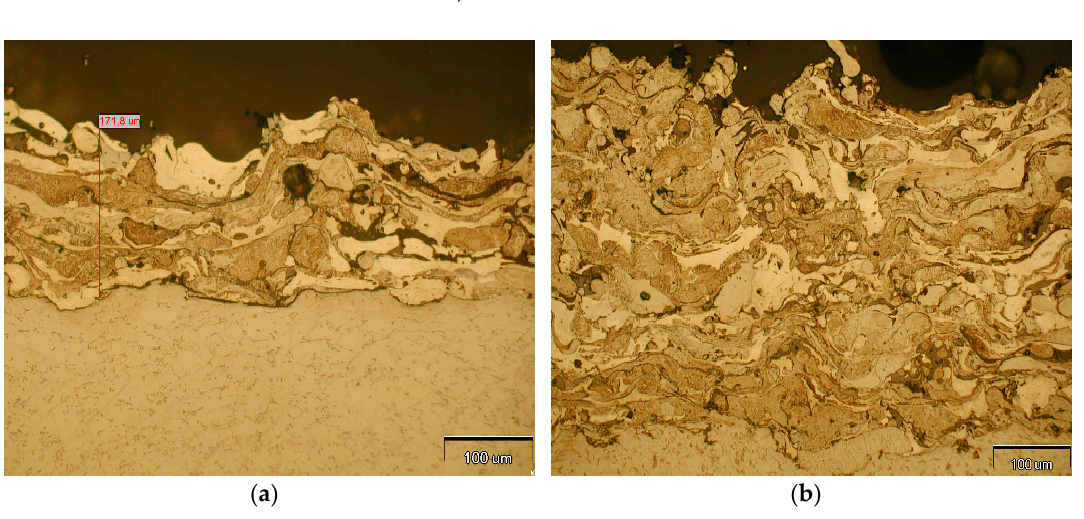
Figure 3. Microstructure of the arc sprayed Fe-Al coating on a steel substrate, with a measurement of thickness, ( a ) one pass-through of spraying, ( b ) two passes.